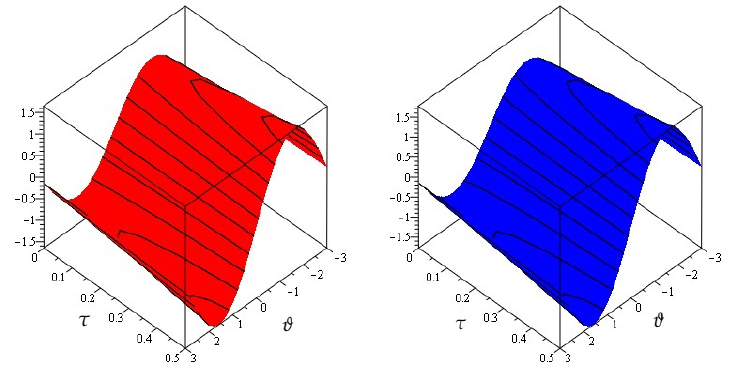
Figure 10. Exact and analytical solution of ν ( ϑ , ζ , z , τ ) at (cid:36) = 1 and 0.8 of Example 3.